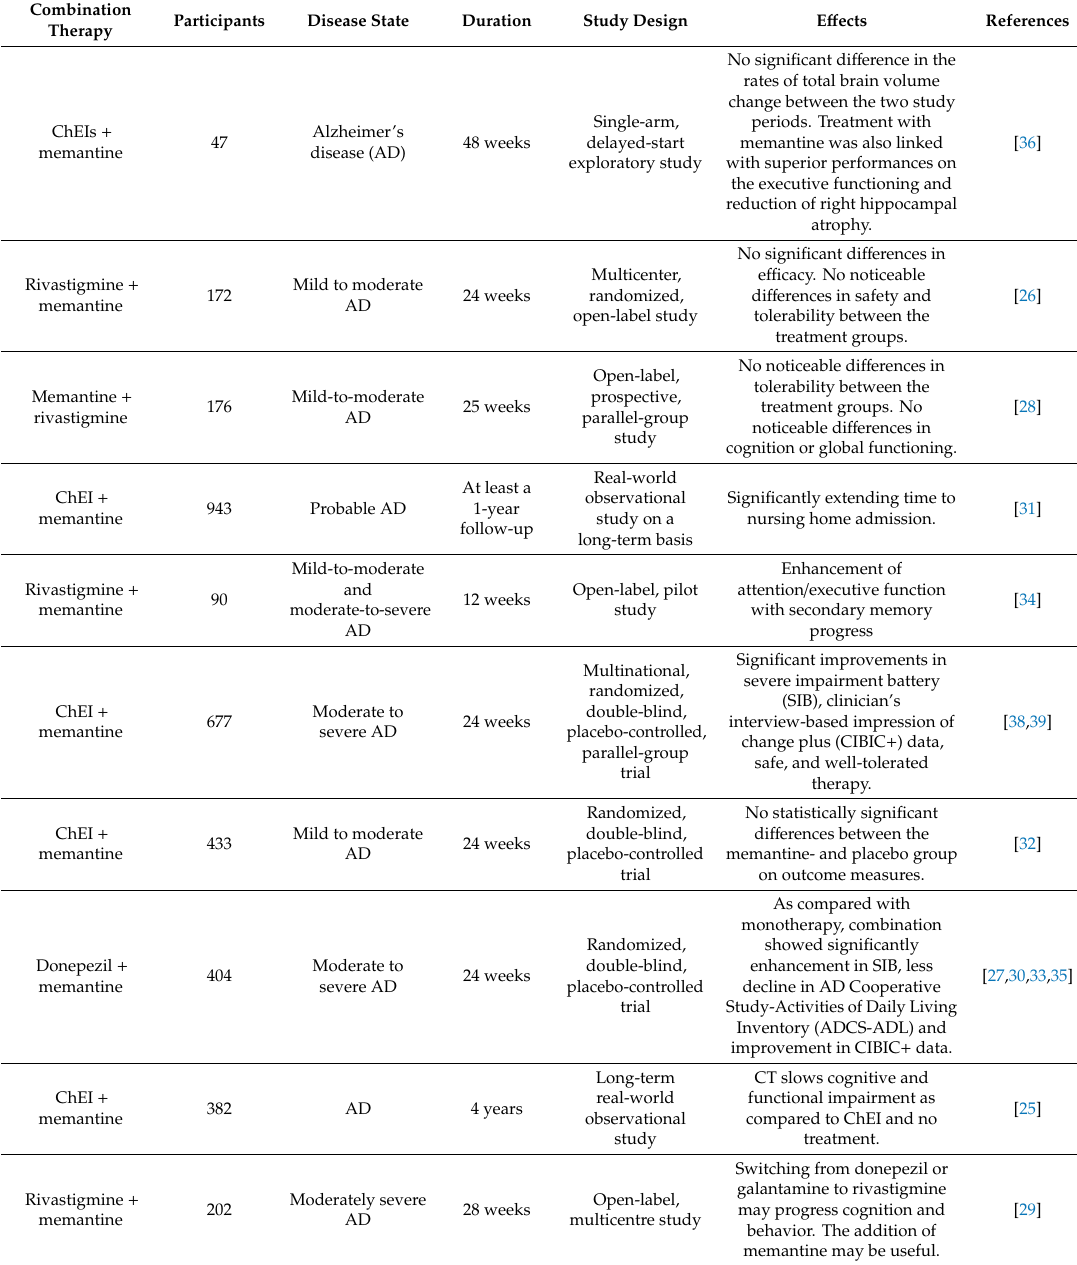
Table 1. Clinical studies on combination therapy with cholinesterase inhibitors and memantine in Alzheimer’s